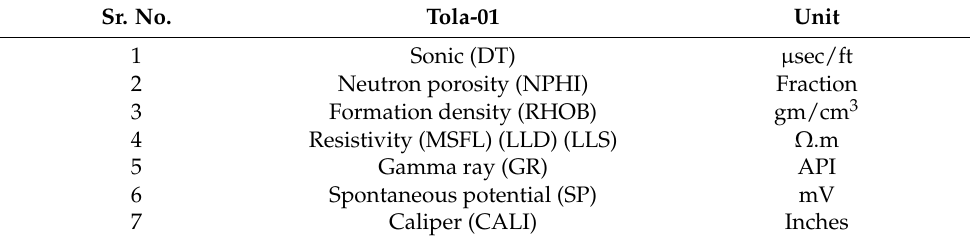
Table 3. Well log data of the study